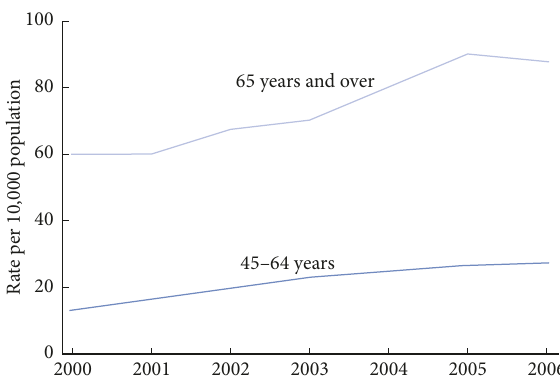
Figure 6: Rate of knee replacements in United States for hospital inpatients aged 45 and above years (2000–2006) [50]. Note: rates for 2000–2006 were calculated using US Census Bureau 2000-based postcensal population estimates. Source: CDC/NCHS, National Hospital Discharge Survey.